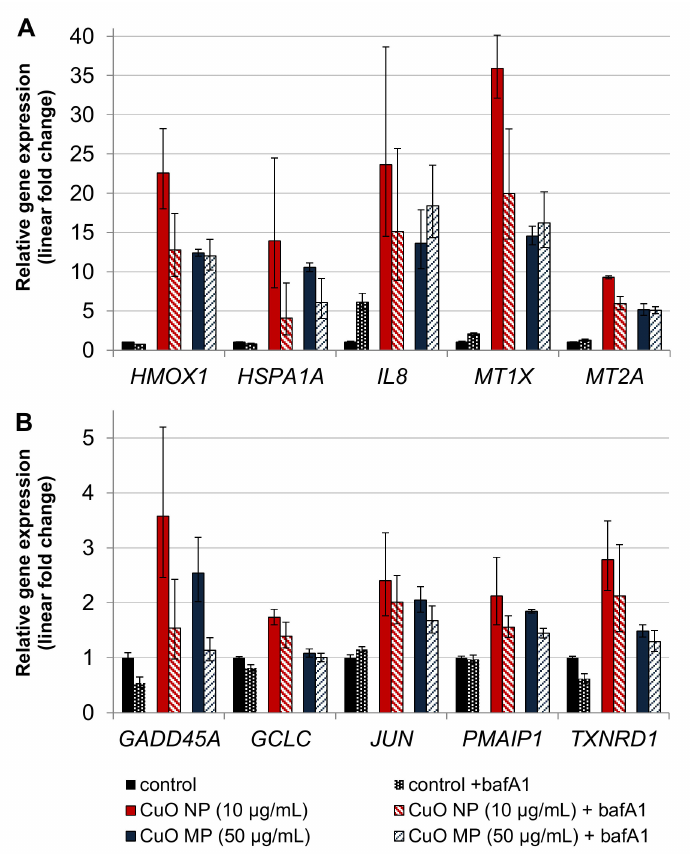
Figure 5. Impact of CuO NP and CuO MP on gene expression related to copper uptake, (oxidative) stress and inflammation ( A ) and DNA damage response, apoptosis, proliferation and anti-oxidative defense ( B ) in the presence or absence of bafA1. BEAS-2B cells were treated with the di ff erent copper compounds with or without bafA1 for 24 h. Shown are mean values of four determinations derived from two independent experiments ±